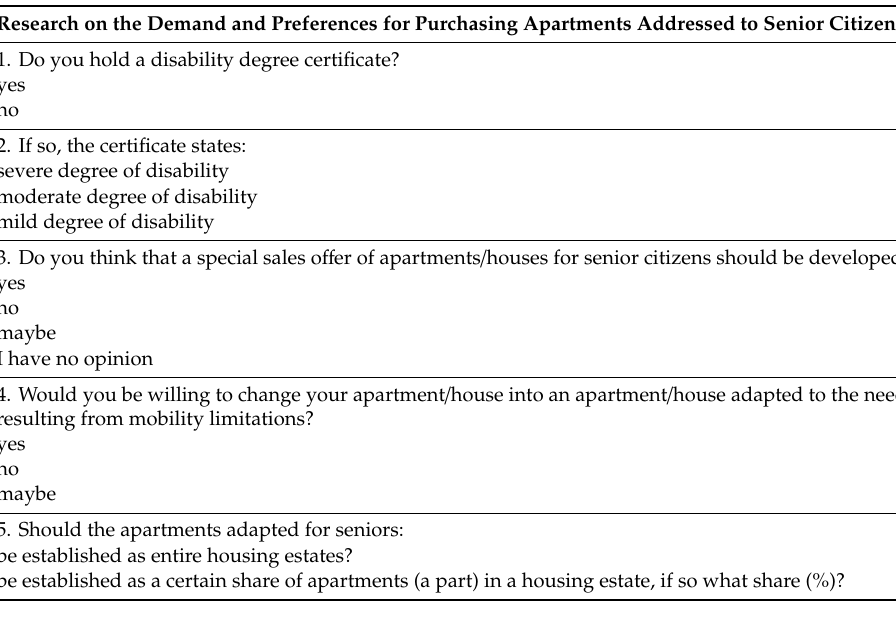
Table 1. Questions asked in the survey.